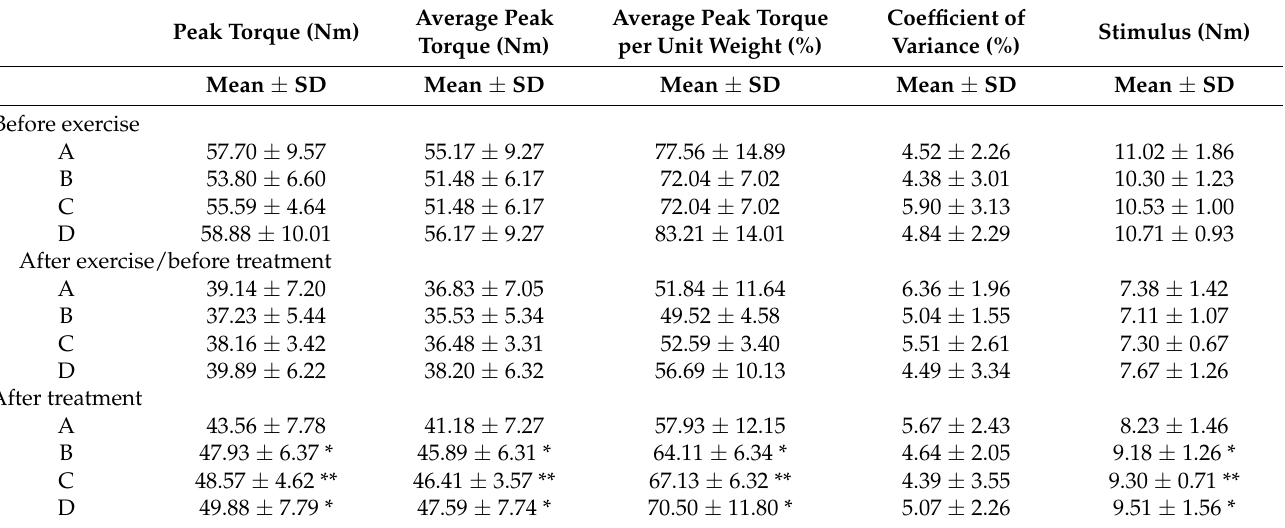
Table 3. Four index contrast of peak torque (Nm), average peak torque (Nm), etc., before exercise, after exercise/before treatment, and after